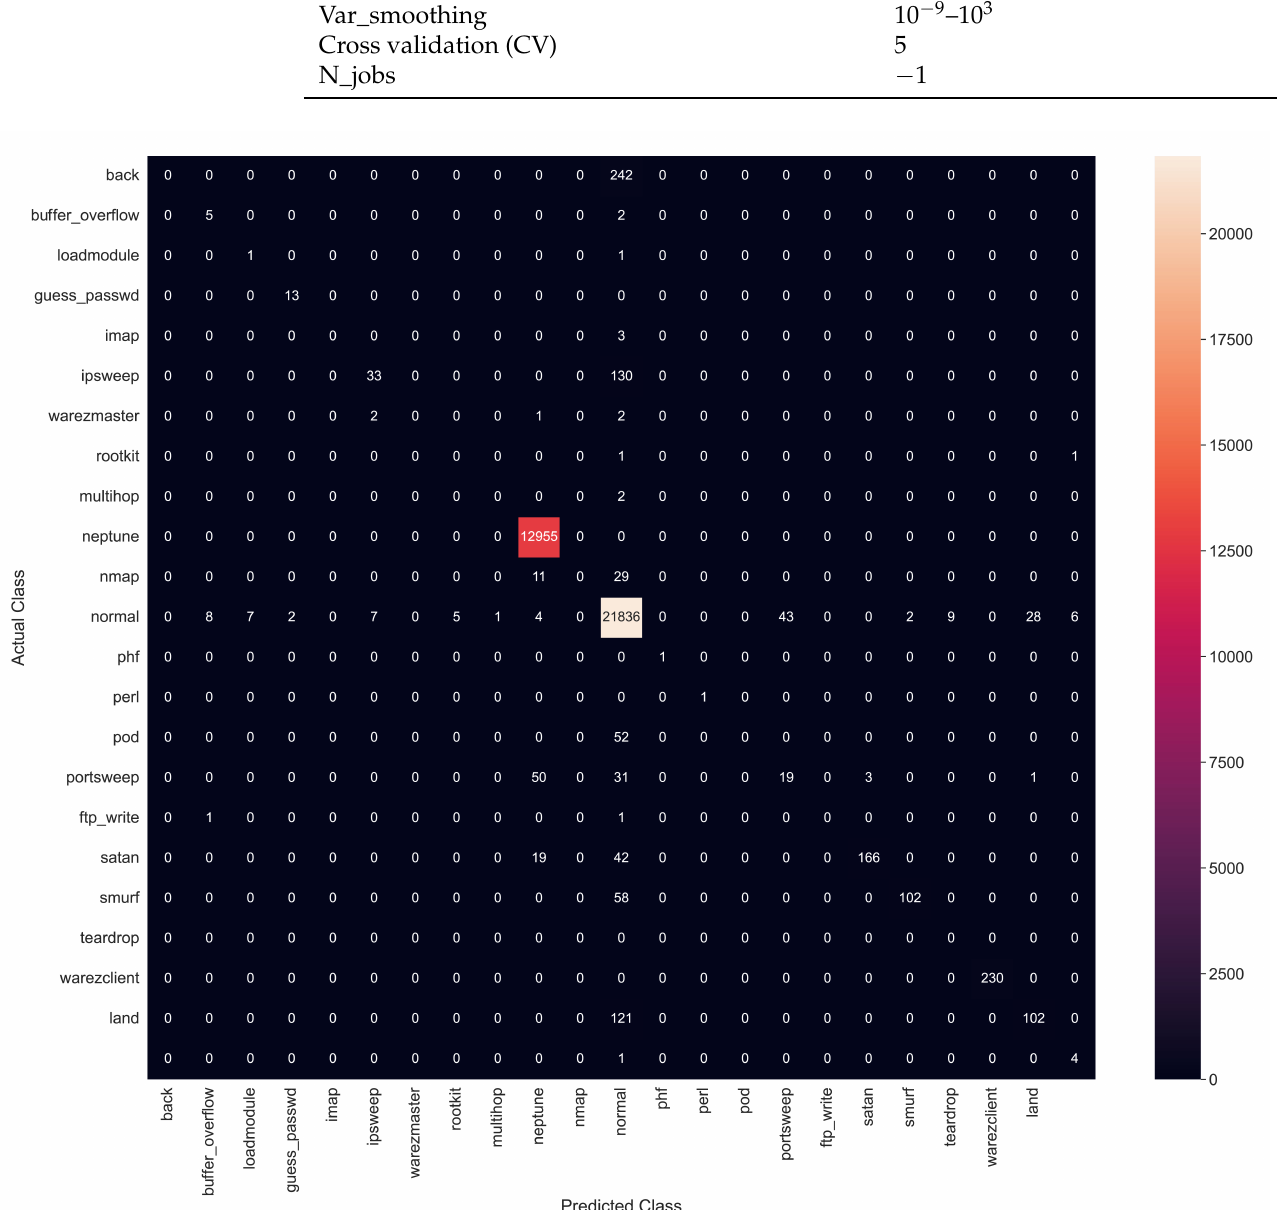
Figure 14. Confusion matrix for Gaussian Naive